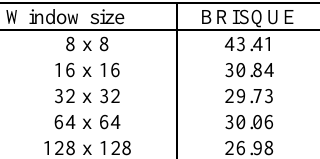
Table 1. BRISQUE scores of the output images generated with Local Histogram Equalization algorithm using five different Table 3. BRISQUE scores of the output generated from true window sizes. color post-flood Landsat images using five enhancement algorithms. Lower BRISQUE score indicates higher output